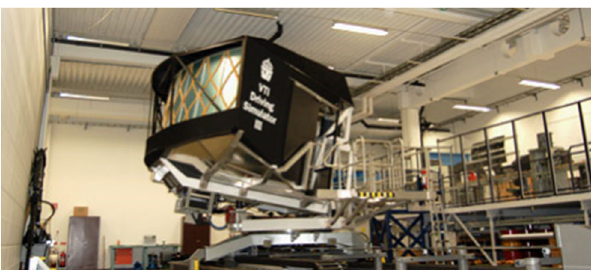
Fig. 1 VTI driving simulator